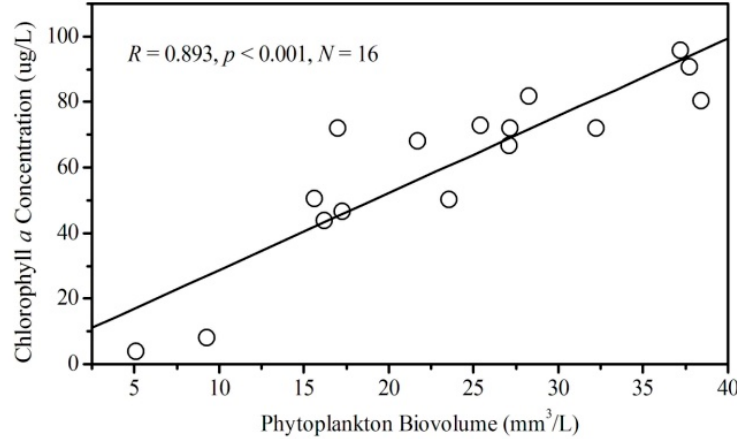
Figure 3. ( a ) The biovolume of phytoplankton and; ( b ) the biomasses of zooplankton in different sites of Lake Qixinghu.